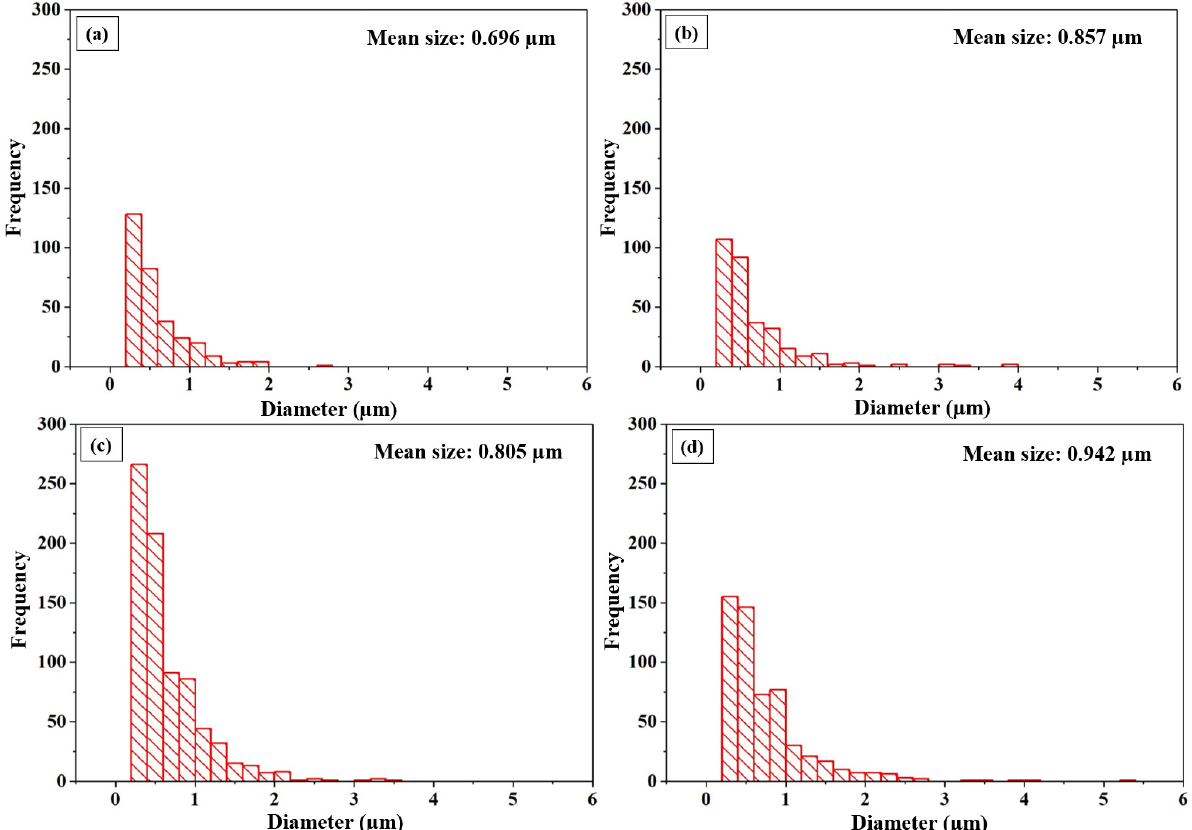
Figure 6. Size distribution histograms of embedded shots onto surfaces of shot-peened AA1050 alloy at ( a ) 0.1 MPa and 100% cover rate, ( b ) 0.1 MPa and 1000% cover rate, ( c ) 0.5 MPa and 100% cover rate, and ( d ) 0.5 MPa and 1000% cover rate.